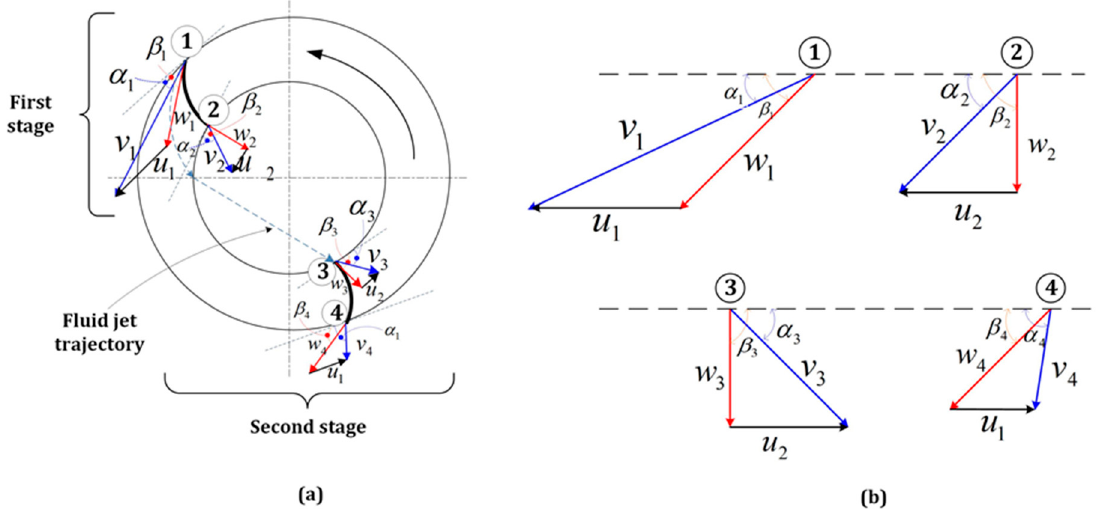
Figure 5. Cross-flow turbine rotor: ( a ) fluid jet trajectory at different locations and ( b ) velocity triangles at Locations 1–4. w 1–4 refer to relative velocities at Points 1–4; u 1 and u 2 refer to peripheral velocities tangent to the outer and inner diameters respectively; v 1–4 refer to actual fluid velocities at Points 1–4.